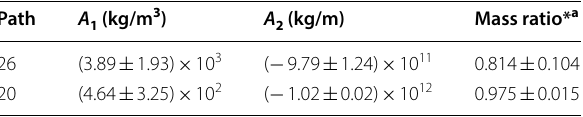
Table 2 Estimated parameters of superposed two